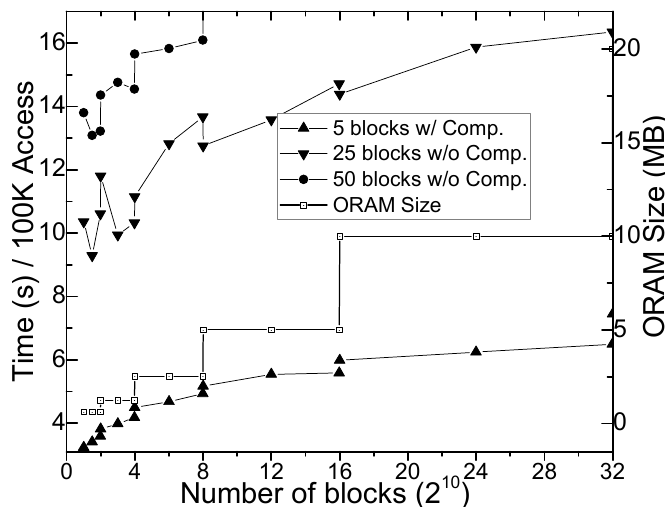
Figure 11. Data size scale with